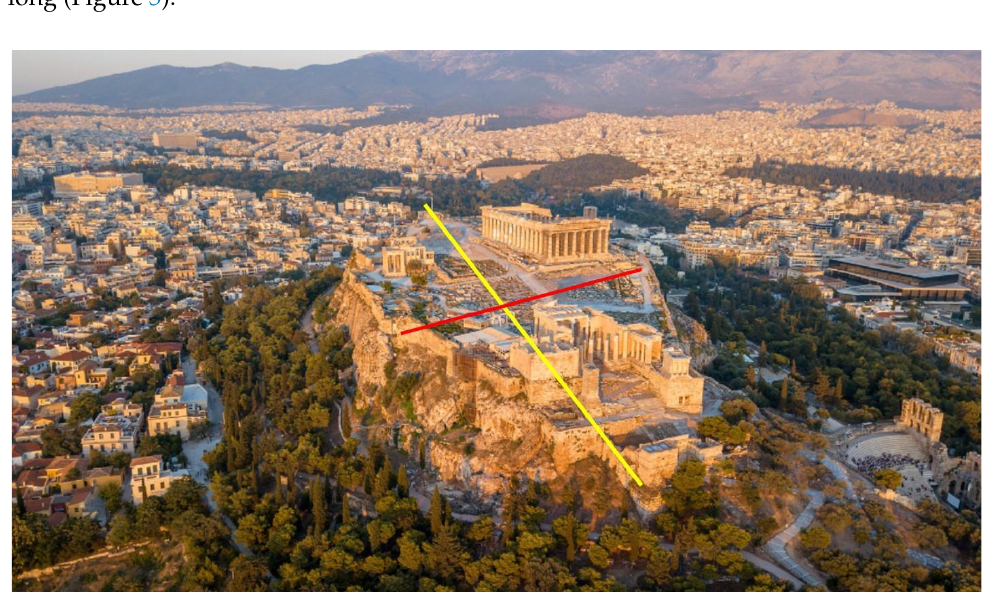
Figure 5. The hill of Acropolis which resembles the shape of an ellipse with its largest axis running east-west, of 250 m length (yellow line), and its smallest axis of about 150 m length (red